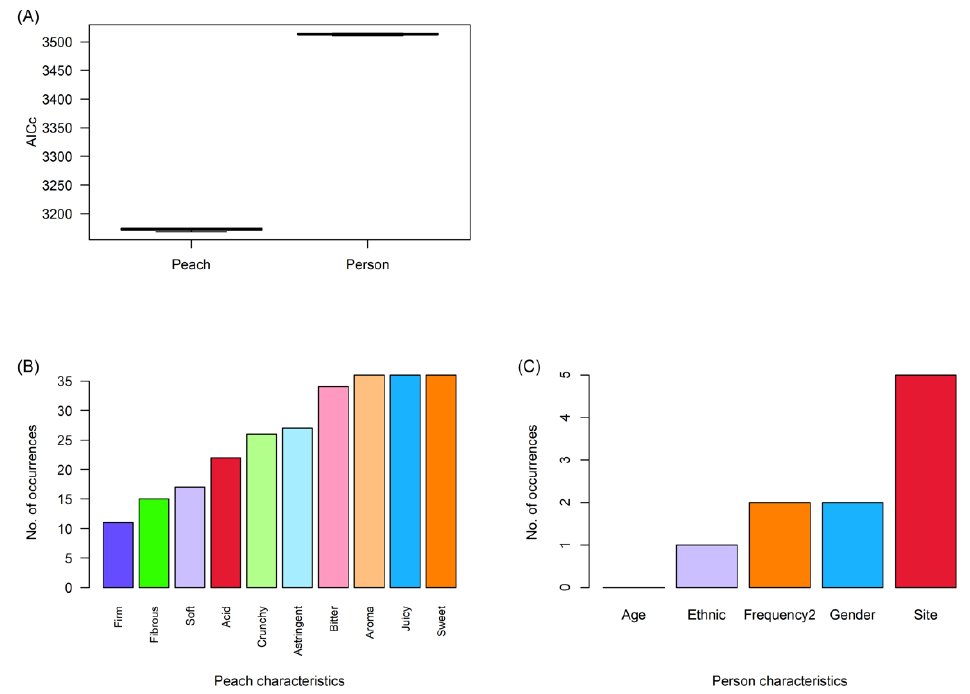
Figure 4. Importance of peach attributes and person characteristics in determining the ‘liking’ rating given to a peach, based on ranking model sets by AICc. All models with a delta value < 6 (acceptable) are included here. ( A ) Boxplots of AICc for peach-based vs. person-based models. ( B ) Number of times each peach attribute appeared in the reduced model set. ( C ) Number of times each person characteristic appeared in the reduced model set.